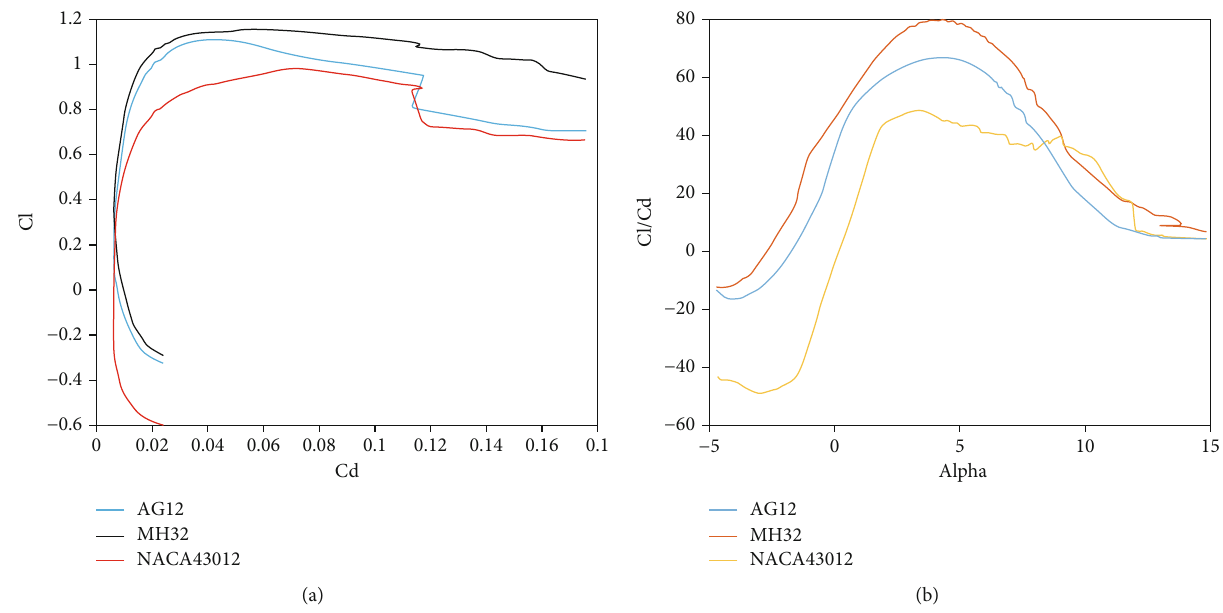
Figure 5: (a) Coe ffi cient of drag with respect to coe ffi cient of lift. (b) Cl/Cd vs. angle of attack.